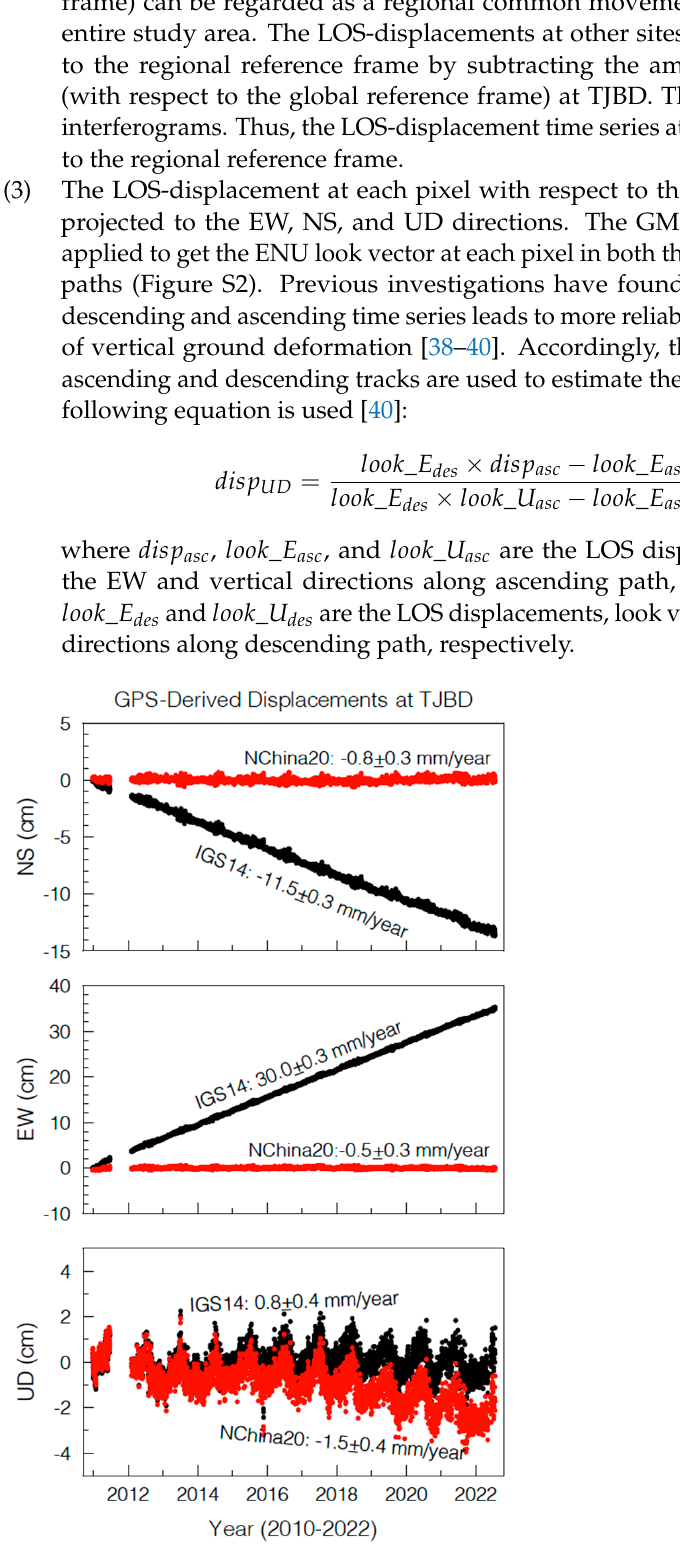
Figure 6. GPS-derived three-component displacement time series at TJBD, with respect to the global reference frame IGS14 and the regional reference frame, stable North China reference frame (NChina20).